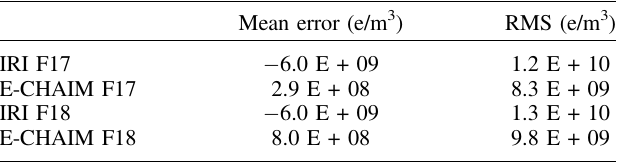
Table 1. E-CHAIM and IRI Mean and RMS errors for DMSP satellites F17 and